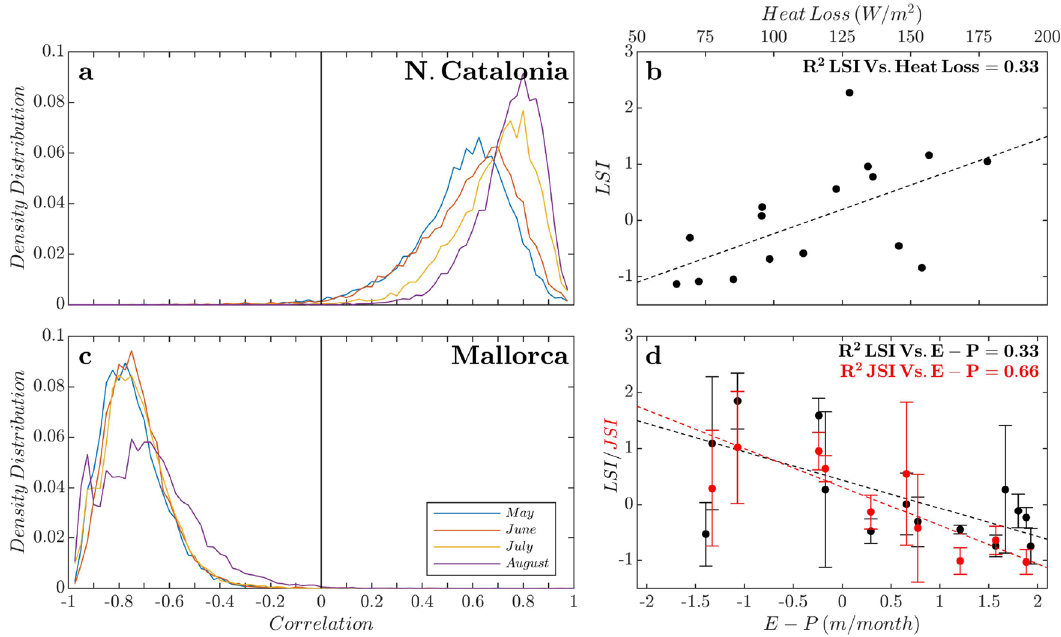
Figure 4. Atmosphere-ocean coupling driving dispersal patterns and proposed mechanisms explaining LPDP interannual variability. Density distribution of the Pearson correlation coefficients between ocean-atmosphere fluxes and PC1 (Fig. 3a,c) for summers/settlement season of jellyfish and lobster, which was obtained by bootstrap resampling (10,000 times) for the two sites: ( a ) Heat loss (HL) vs. PC1 for North Catalonia (NCat) (Fig. 3a). ( c ) (Evaporation-precipitation, E−P) vs. PC1 for Mallorca (Fig. 3c). Linear relationship of the atmosphere-ocean fluxes and LPDP field records for both sites, Lobster Settlement Index (LSI) and Jellyfish 2 = 0.33 Stinging Index (JSI). ( b ) For NCat, HL vs. LSI ( R ; p-value = 0.021 , n = 16 ). ( d ) In Mallorca, (E−P) vs. 2 = 0.33 2 = 0.66 LSI ( R ; p-value = 0.003 , n = 14 ) and (E-P) vs. JSI ( R ; p-value = 0.005 , n = 10 ). More details in Supplementary Table S2, Supplementary Information). We found synchronic patterns for both LPDP: LSI vs. JSI 2 = 0.65 ( R ; p-value = 0.005 , n = 10